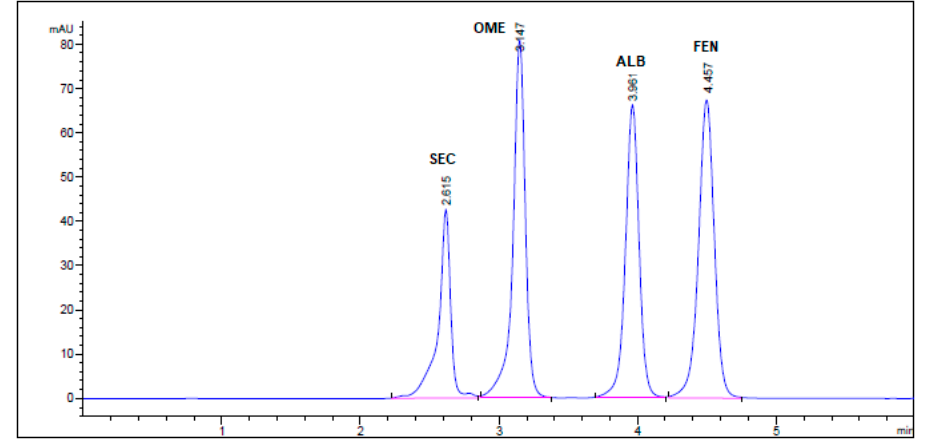
Figure 4. HPLC Chromatogram of Secnidazole ® , Omez ® , Alzental ® , and Curafluke ® dosage forms. All optimum chroma- tographic conditions are stated in Table 1.